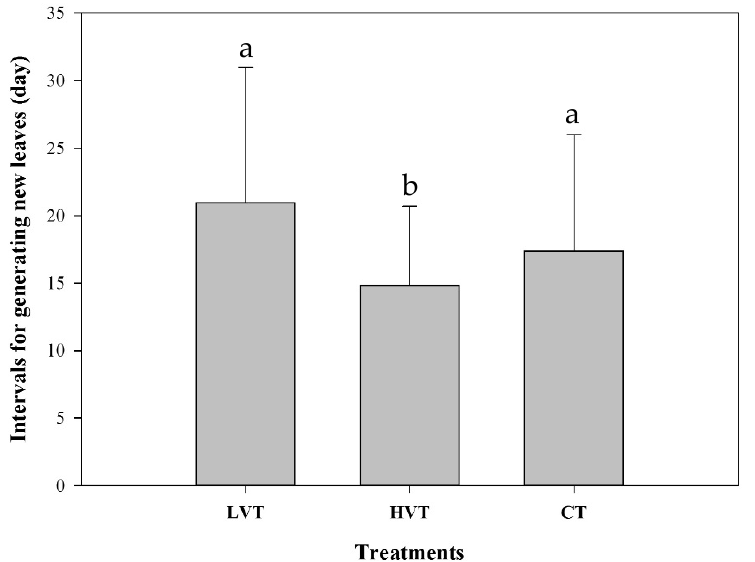
Figure 12. Time intervals for generating new leaves for strawberries for each treatment. Means followed by the same letter are not significantly different ( p < 0.05, Scheffé test). LVT is the low-temperature oscillation pattern, HVT is the high-temperature oscillation pattern, and CT is the fixed temperature regime.